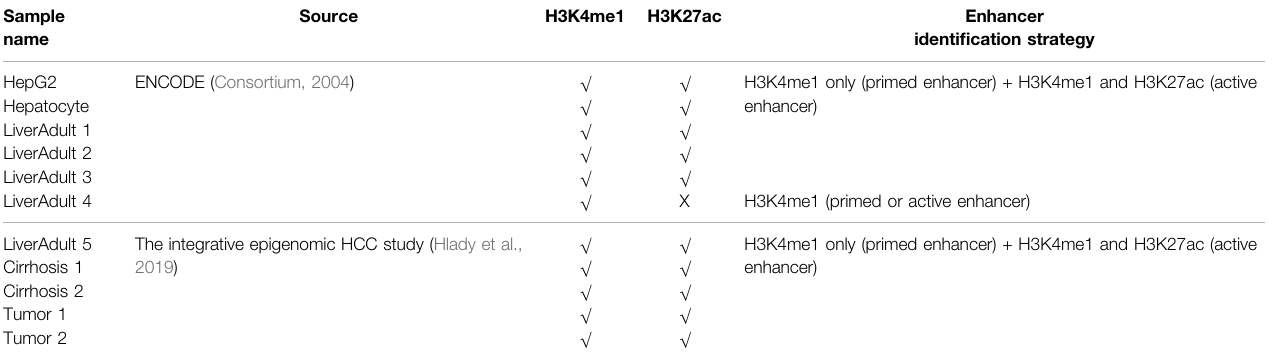
TABLE 1 | Characteristics and enhancer identi fi cation strategies applied for 11 liver-relevant ChIP-seq samples.